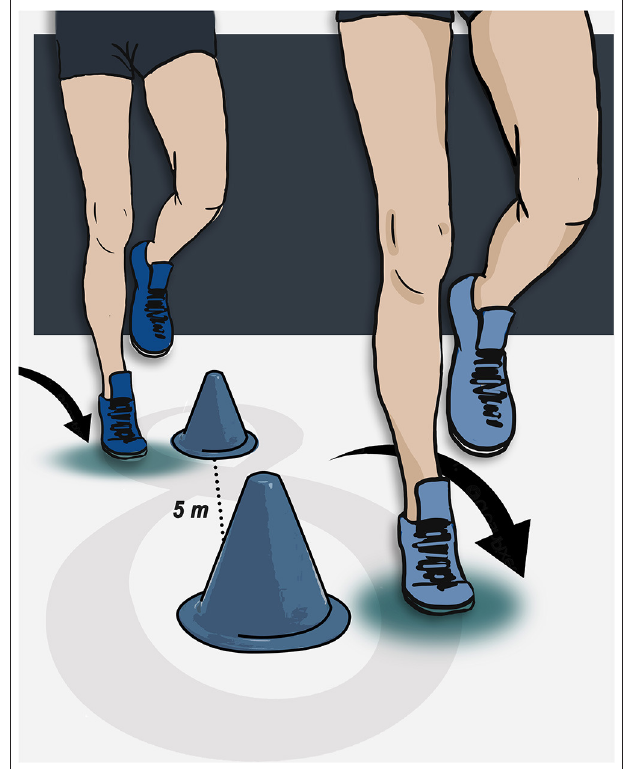
FIGURE 4 | Figure-of-8 test of the right